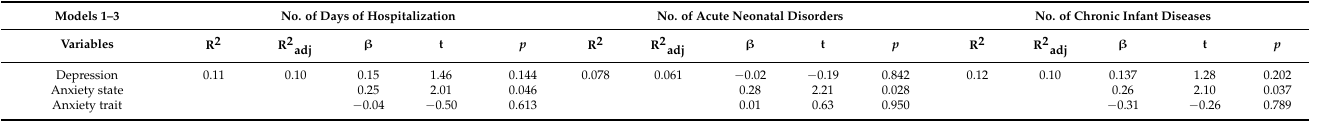
Table 3. Coefficients in the linear regression